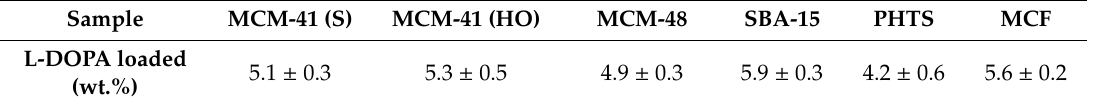
Table 4. L-DOPA loaded within the samples.